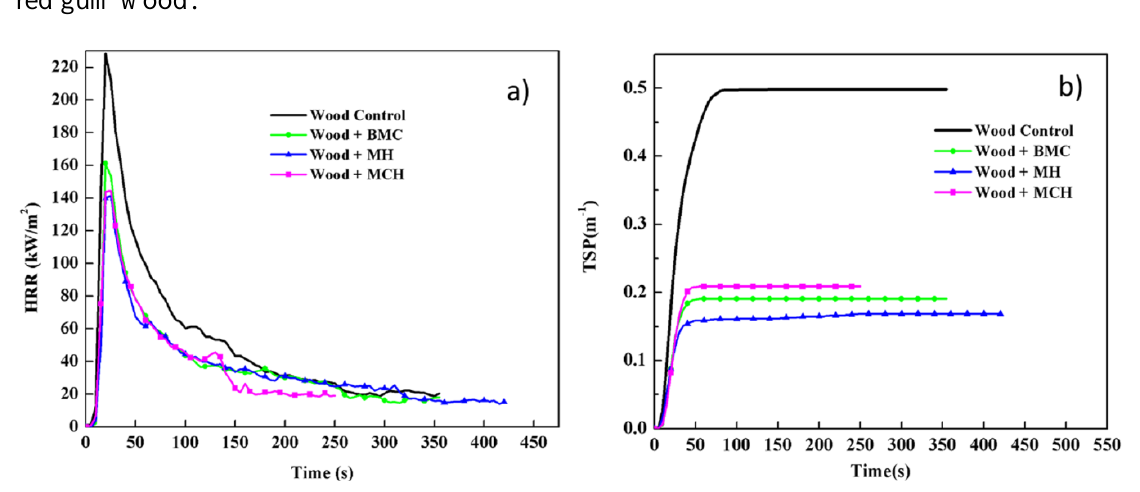
Figure 1. HRR ( a ) and TSP ( b ) as a function of time for untreated and magnesium treated red gum wood.